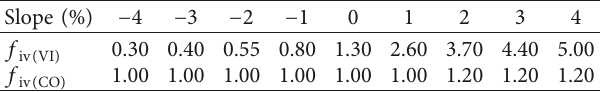
Table 3: Slope related with f condition).